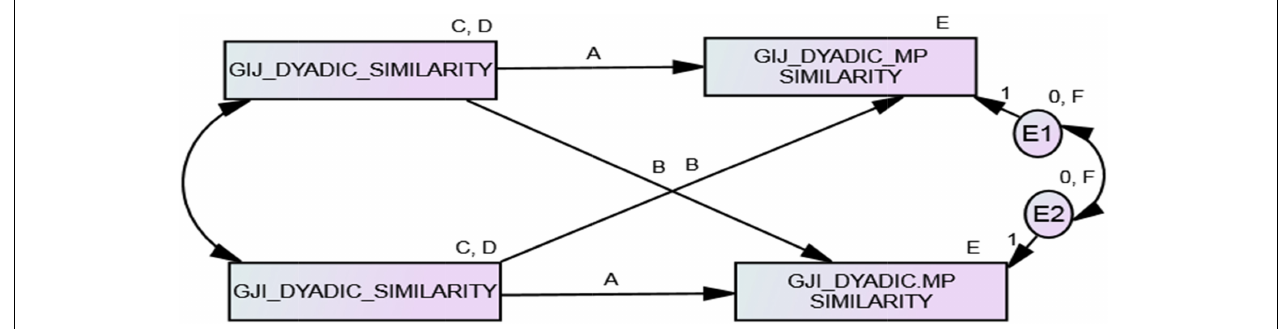
FIGURE 6 | Full dyadic ARRMA for indistinguishable dyads with Olsen and Kenny (2006) constraints. G indicates an SRM relationship effect (gamma). TABLE 8 | Full dyadic ARRMA with indistinguishable dyads: unconstrained and Olsen-Kenny constraints. Unconstrained model Olsen-Kenny